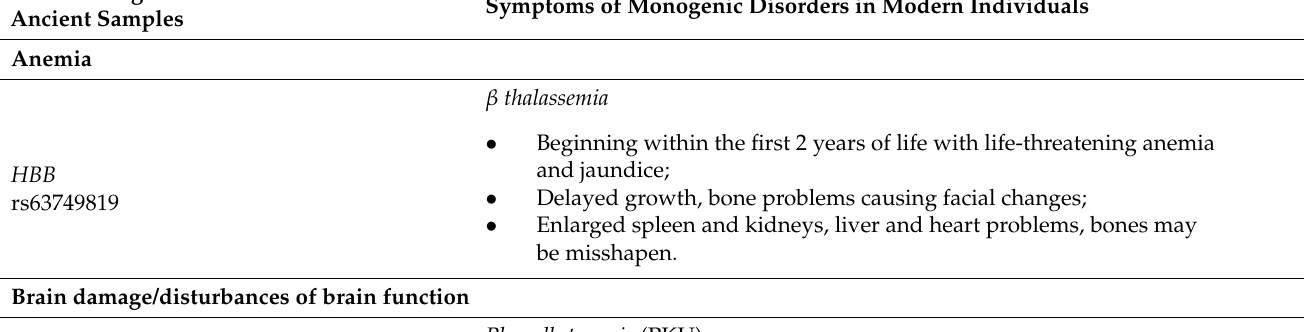
Table 4. Pathogenic mutations in ancient populations and their clinical picture in modern individuals. Symptoms of Monogenic Disorders in Modern